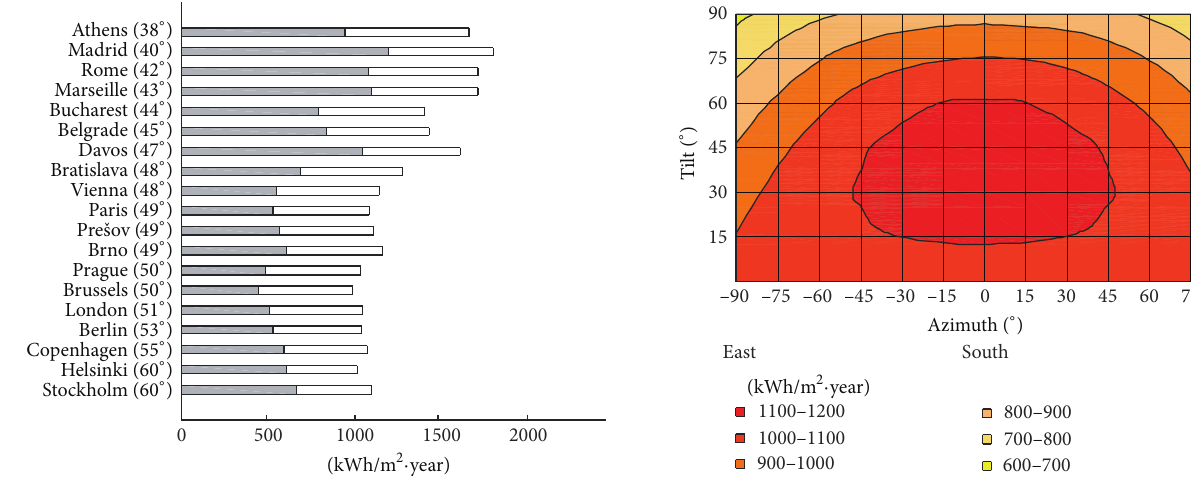
Figure 4: Dependence of the amount of energy incident per unit area on the tilt and azimuth